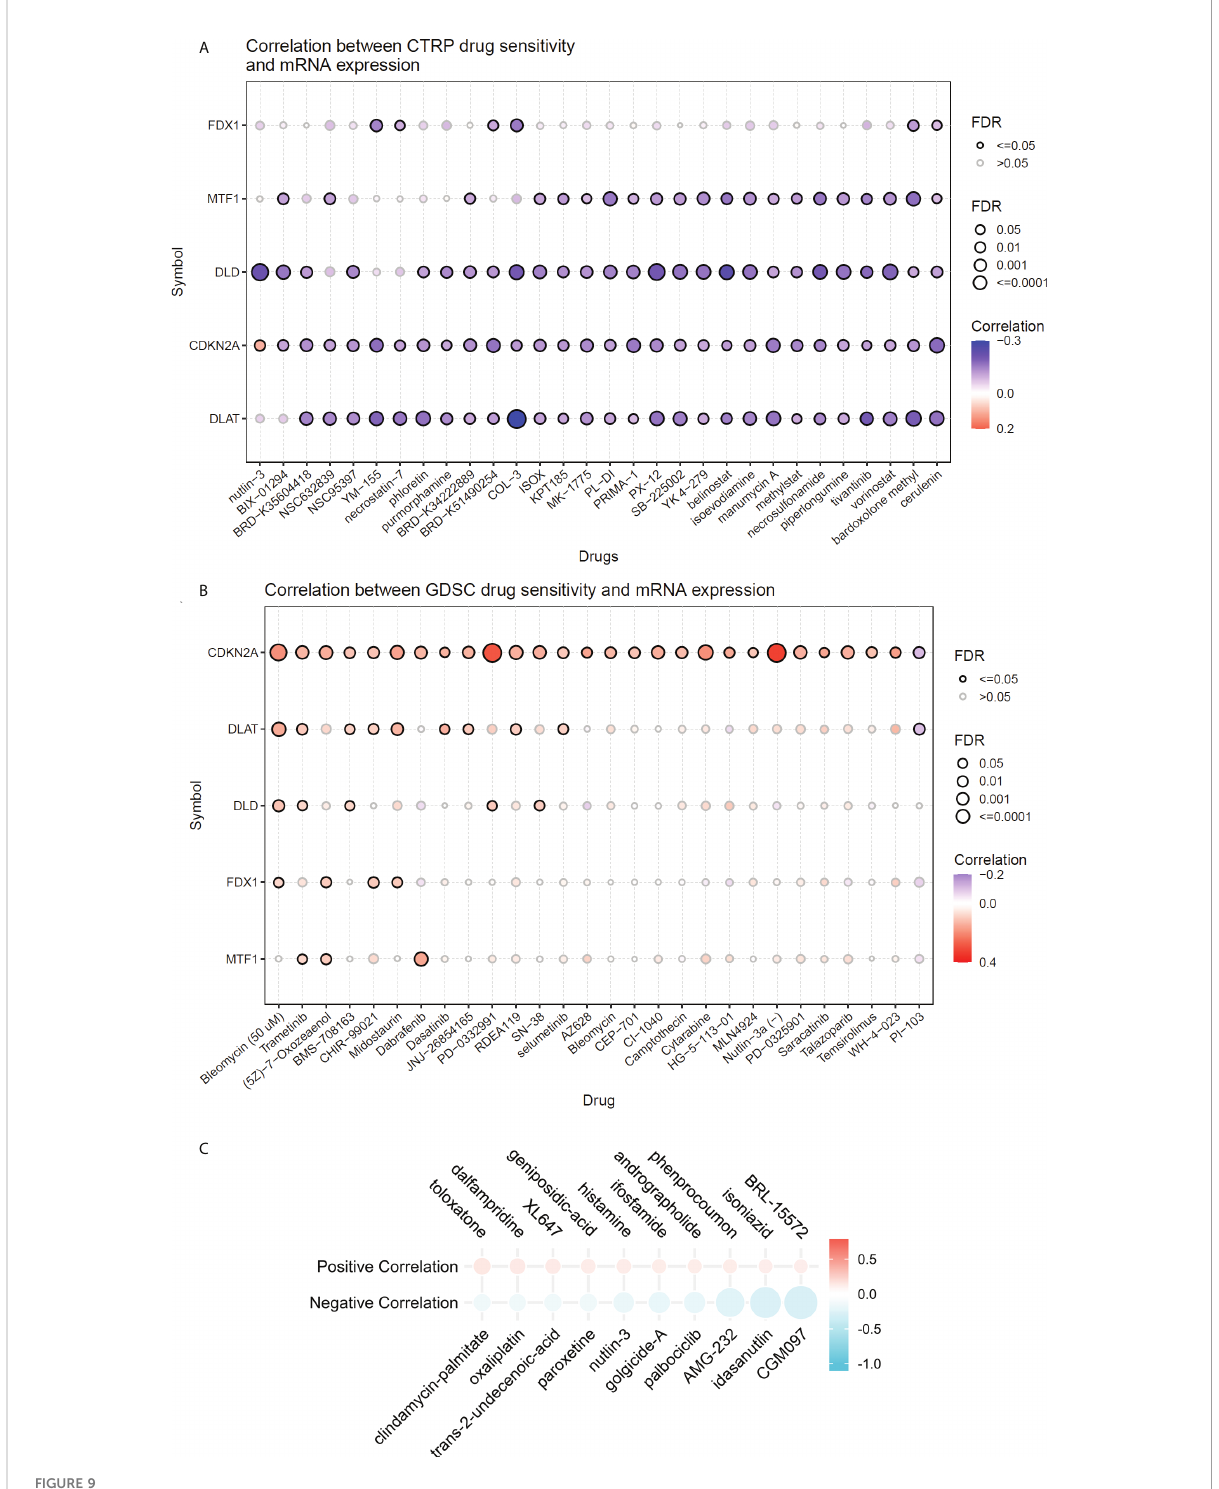
FIGURE 9 The relationship between risk scores and drug sensitivity. (A) The relationship between risk scores and drug sensitivity in CTRP database. (B) The relationship between risk scores and drug sensitivity in GDSC adtabase. (C) The relationship between risk scores and drug sensitivity in PRISM